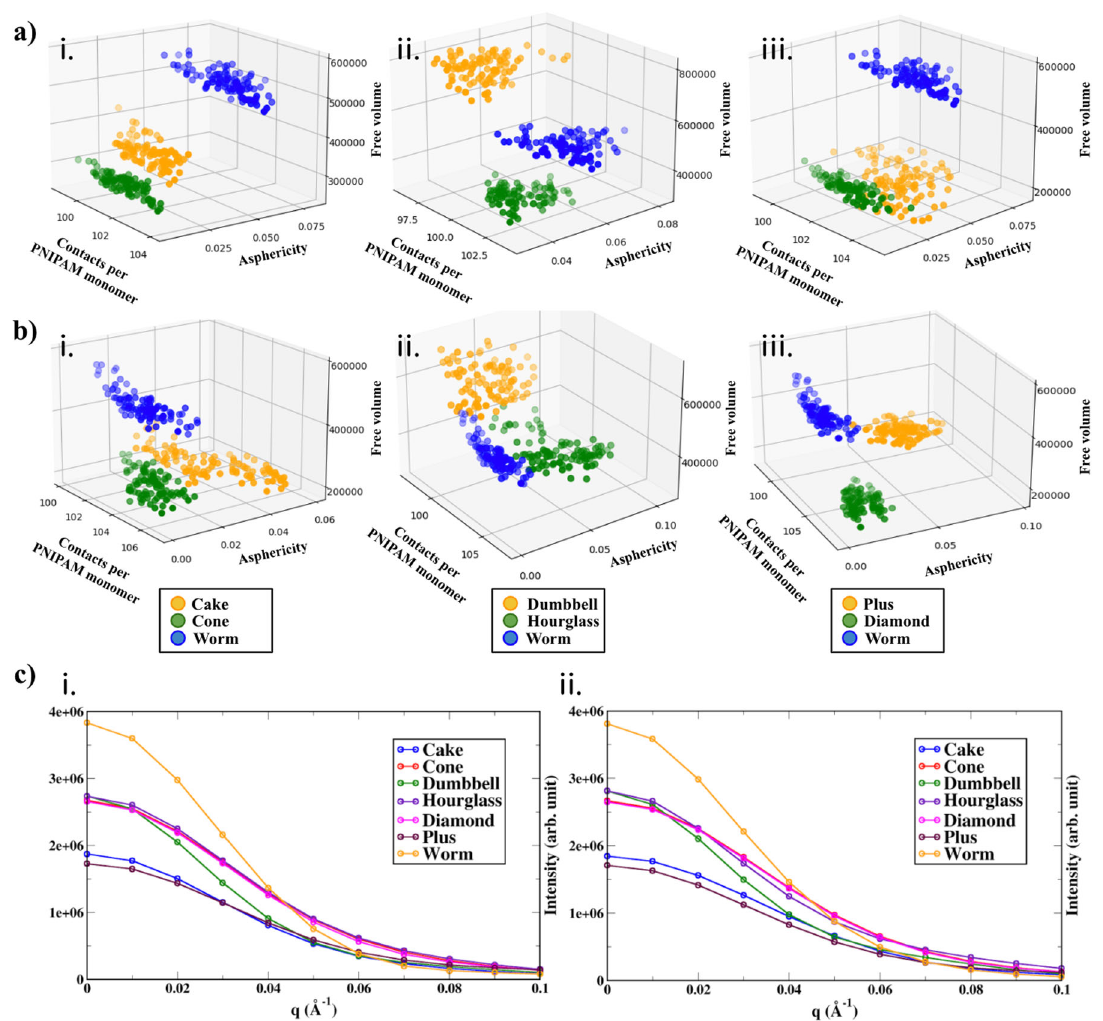
Fig. 2 Conventional analysis of compactness and shapes of BBPs. Three-dimensional (3D) plots plotted using the BBP free volume, contacts per PNIPAM monomer and asphericity data comparing analogous BBP pairs with worm-like BBPs at a 300 K, and b 320 K. The analogous pairs include (i) Cake-Cone, (ii) Dumbbell-Hourglass, and (iii) Plus-Diamond shaped BBPs. c Small angle neutron scattering (SANS) spectra plotted for all BBPs at (i) 300 K and (ii) 320 K. All data generated for the last 50 ns of the simulation run. Figure legends present alongside the fi